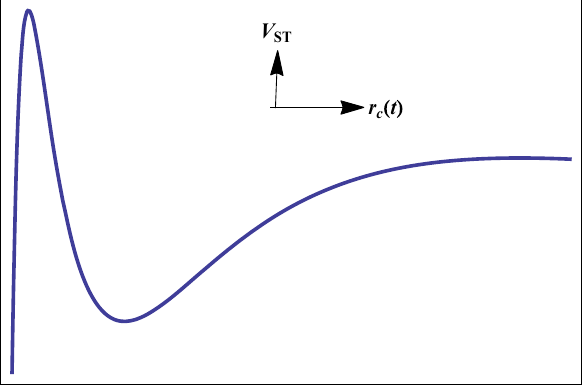
(cid:8) (cid:9) = ˜ T ( t ) for a = 1, b =